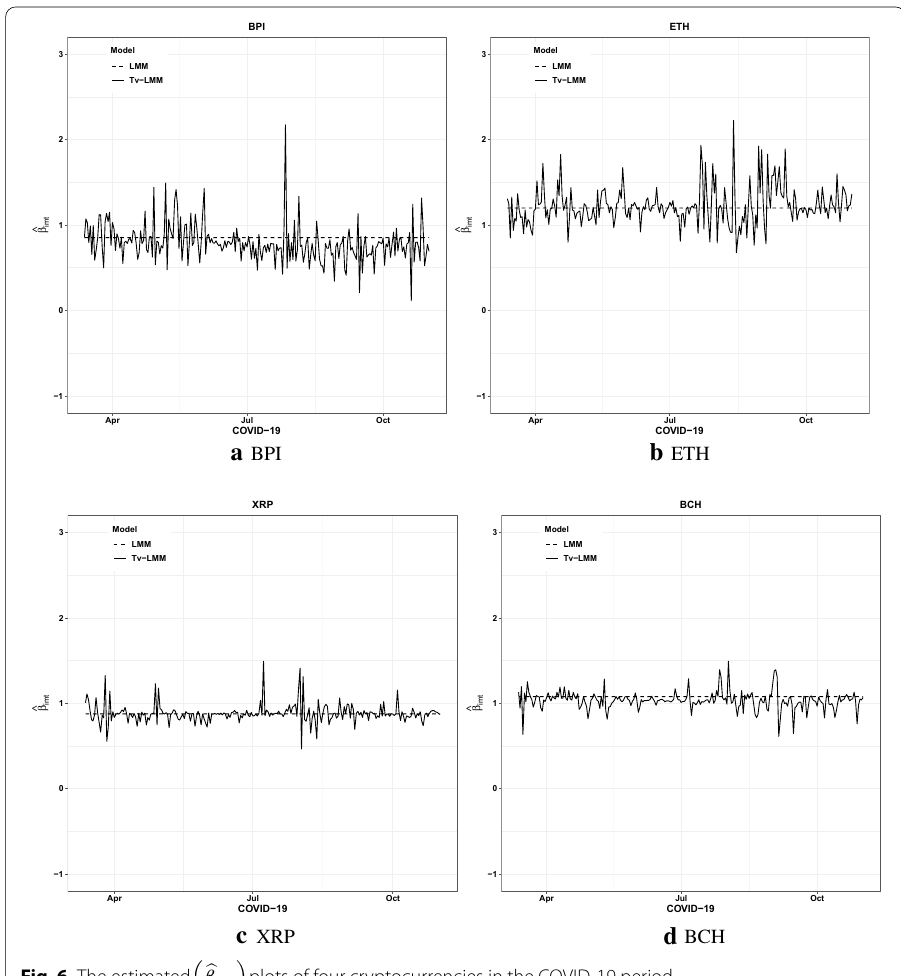
Fig. 6 The estimated